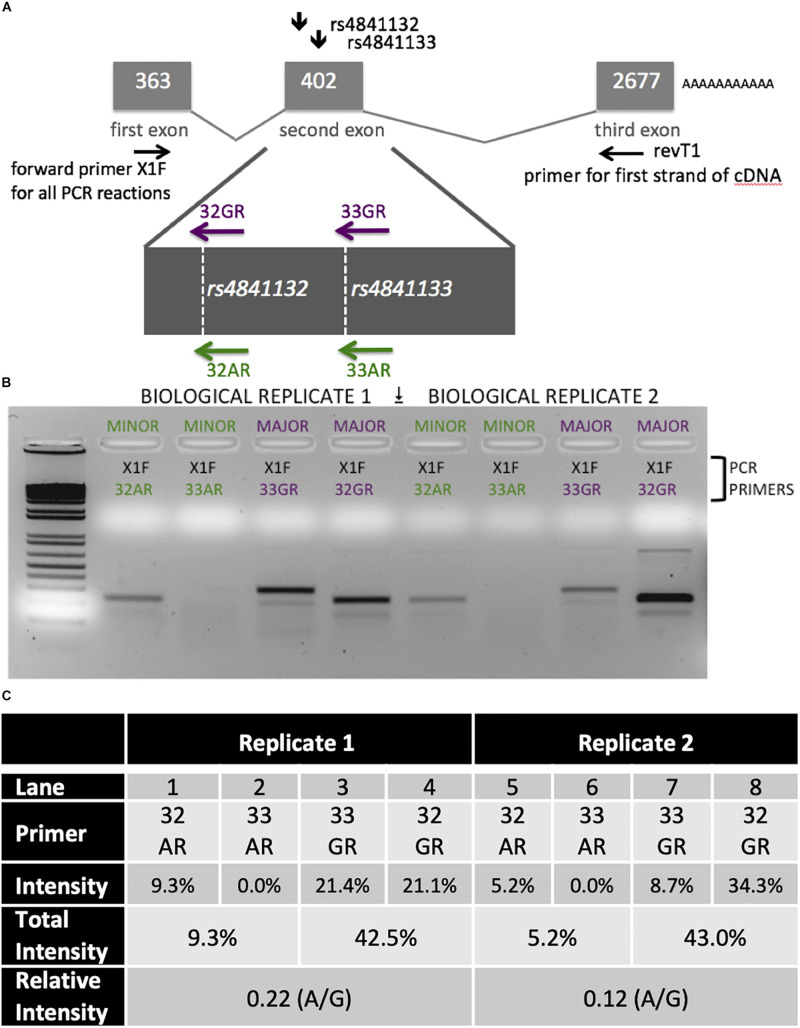
Analysis of LOC157273 transcription in primary hepatocytes from a heterozygous rs4841132 A/G donor demonstrates decreased transcription of the minor (A) allele. (A) RNA was transcribed into cDNA using a gene-specific strand-specific primer for two replicates. (B) Aliquots of cDNA were amplified with PCR primers seated in the first exon (black, X1F) and allele-specific primers that recognize only the major allele (magenta, 32G or 33G) or minor allele (green, 32A or 33A). The X1F-32 reaction yields a PCR product of 231 bp, while the X1F-33 reaction yields a PCR product of 302 bp. (C) Image-based quantification of the X1F-32 and X1F-33 bands from the minor allele compared to the major allele using the ImageJ software. Total intensity: sum of 32GR/33GR or 33AR/32AR lanes. Relative Intensity: quantification of the rs4841132-A minor allele intensity compared to the rs4841132-G major allele intensity.